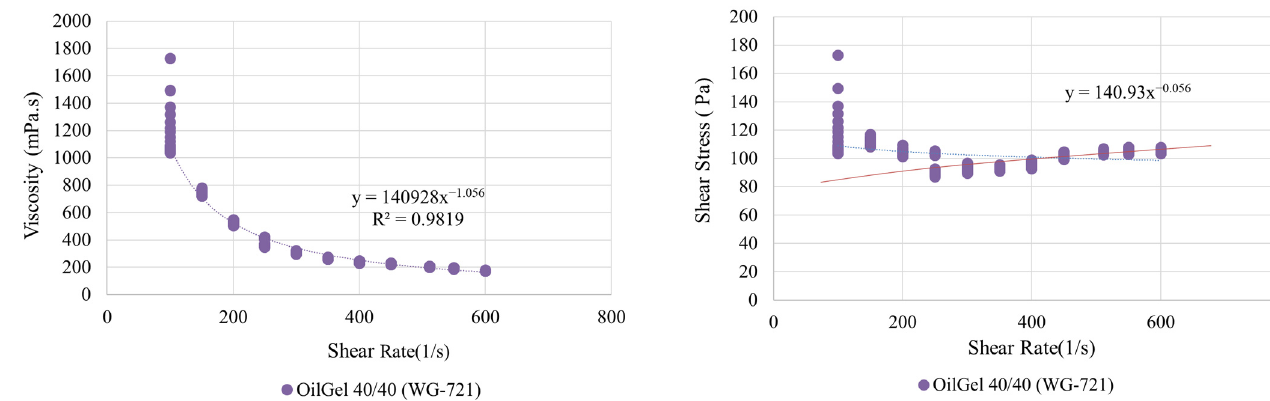
Figure 8. Viscosity as the function of shear rate ( left ) and dependence of shear stress on shear rate ( right ) for the high viscosity oil-based fluid.